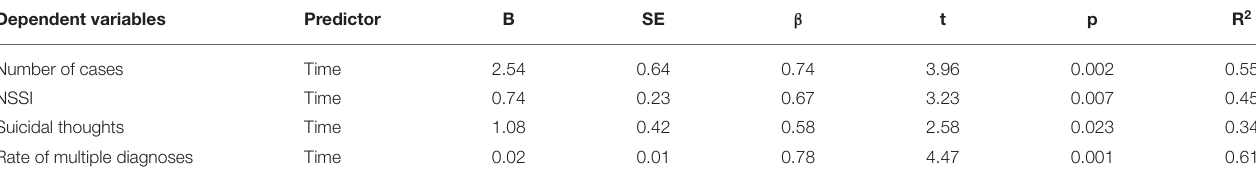
TABLE 3 | Results of linear regression models with time predicting number of cases, NSSI, suicidal thoughts and rate of multiple diagnoses. Dependent variables Predictor B SE